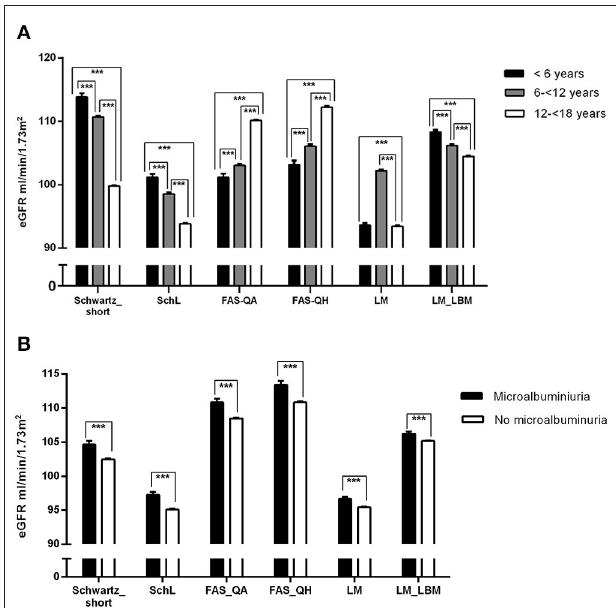
FIGURE 1 | (A) eGFR (36,780 patients) calculated by different formulae for three age groups. Estimates ( ± standard error) are derived from linear regression models adjusted for age, sex, diabetes duration, and BMI. *** p < 0.0001. (B) eGFR (27,744 patients) sorted into two groups by the characteristic “microalbuminuria” or “no microalbuminuria,” respectively. Estimates ( ± standard error) are derived from linear regression models, adjusted for age, sex, diabetes duration, BMI, HbA1c, antihypertensive medication. *** p < 0.0001.